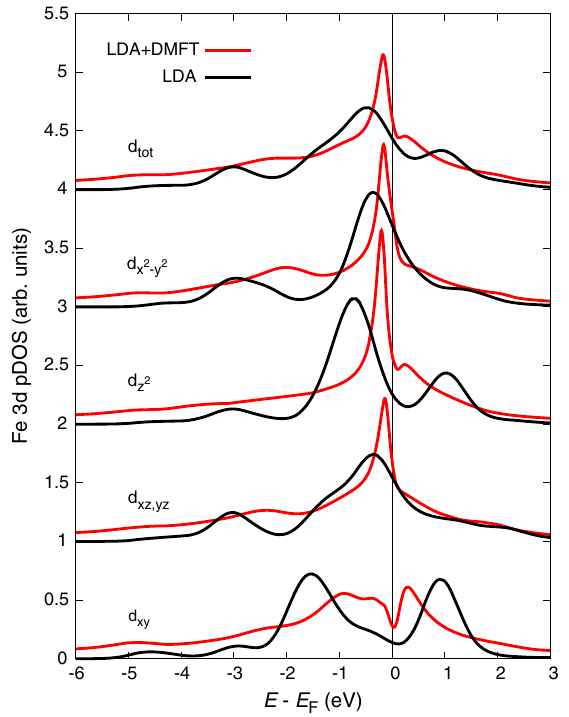
FIG. 3. Fe 3 d pDOS for BaFe 2 As 2 calculated with LDA density functional theory (black) and dynamical mean field theory based on LDA DFT (red). Curves are offset vertically for